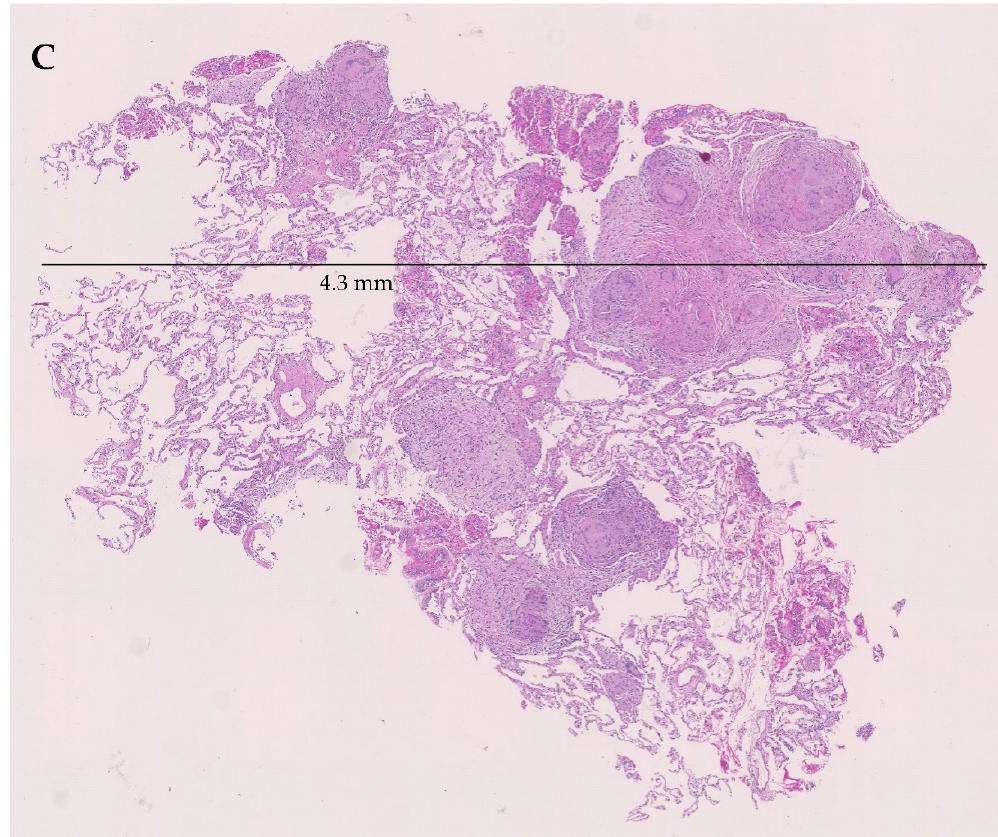
Figure 1. Direct comparison of the dimensions of TBLC and TBLF. ( A ) Macroscopic image of 3 TBLCs (top row, probe size 1.7 mm, freezing time 5 and 6 s) and 3 TBLFs (bottom row, forceps 2.2 mm) (scale in mm); ( B ) Microscopic image (2.5× magnification) of TBLF—diameter 0.9 mm; ( C ) Microscopic image (2.5× magnification) of TBLC—diameter 4.3 mm.